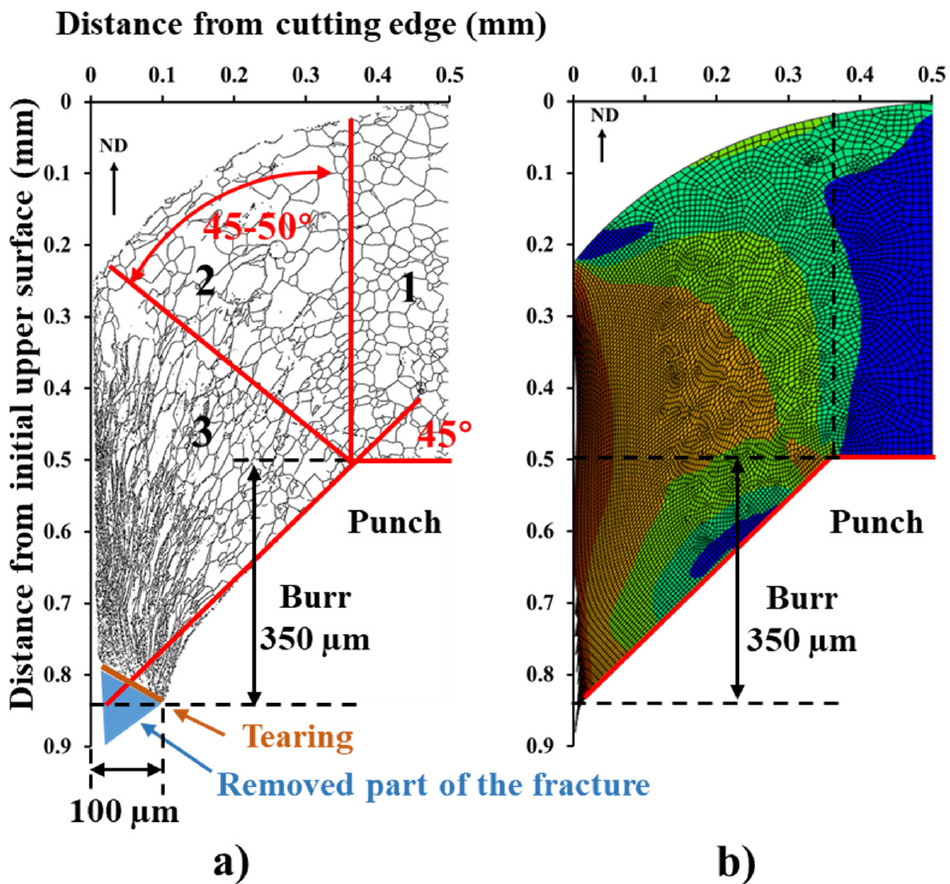
Figure 7. ( a ) Blank map obtained from EBSD analysis at the cutting edge of the punched sample. ( b ) Diagram of burr, obtained by FE simulation with blunt tools. Black lines shown in ( a ) are the grain boundaries with a misorientation greater than 15°. The brown line and blue area at the end of the burr correspond to the direction of tearing failure and the removed part of burr after tearing failure, respectively.